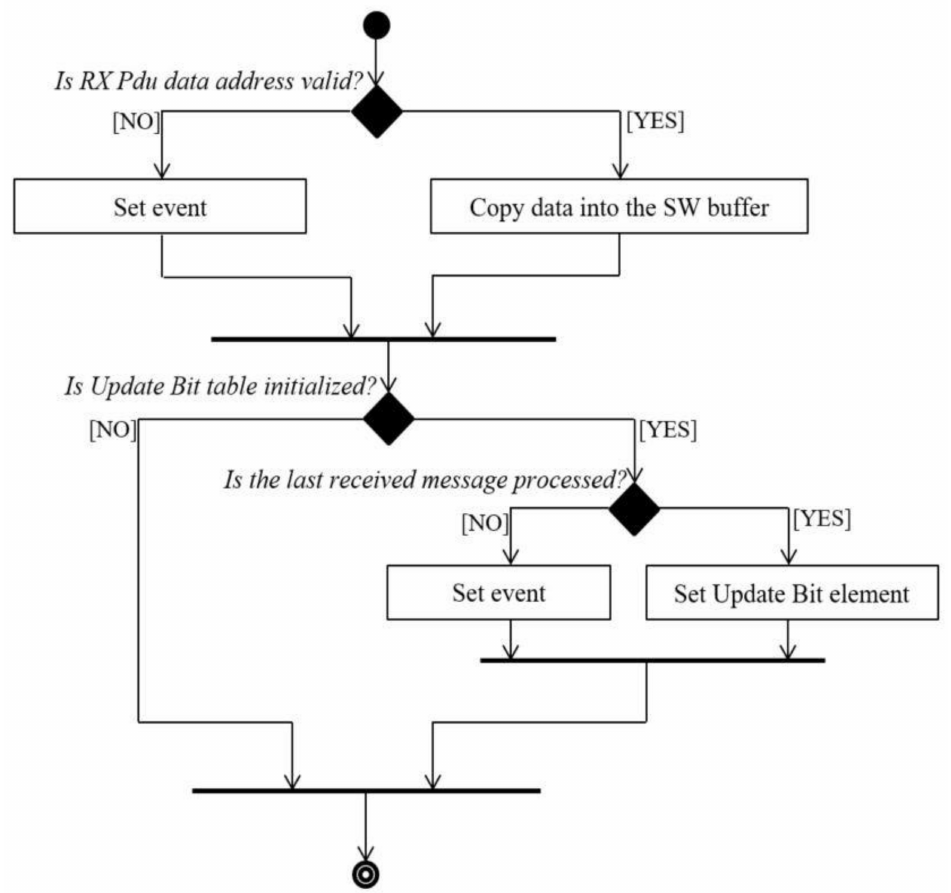
Figure 10. PDA reception through the Pda RxIndication function